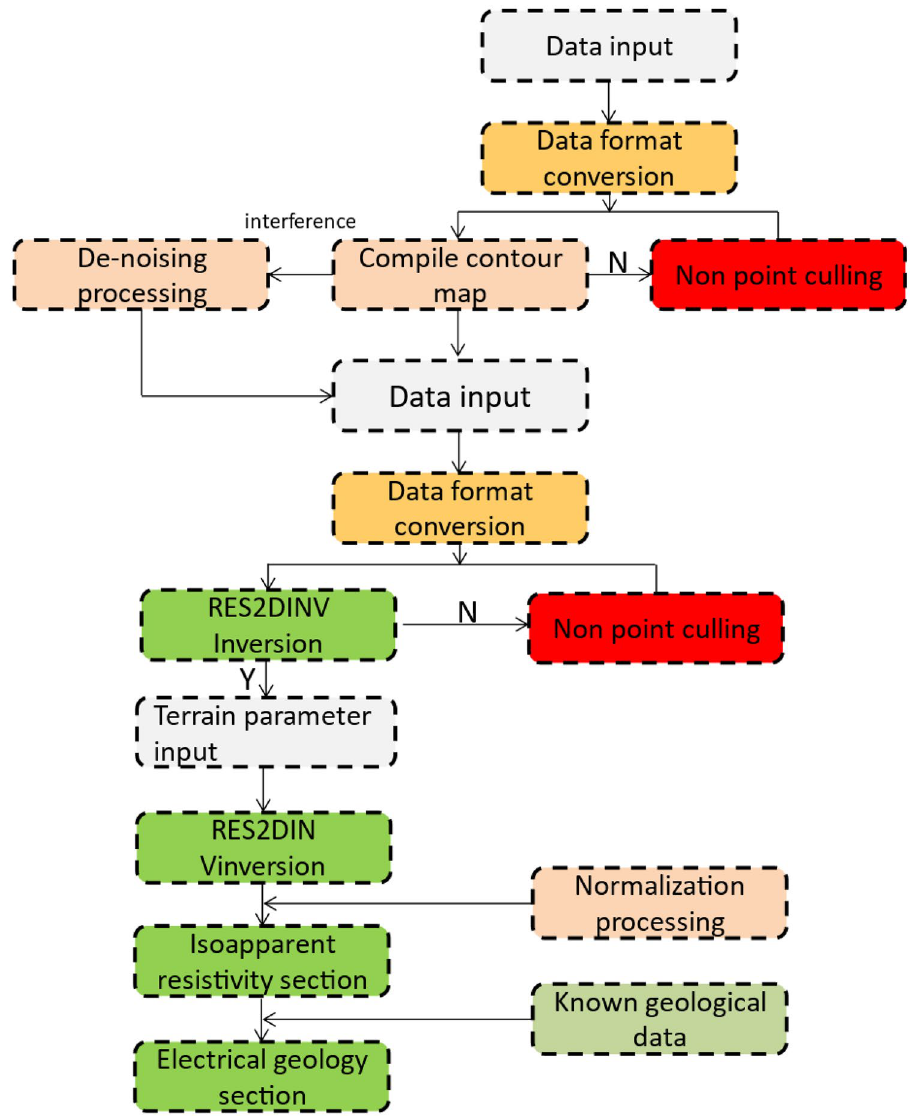
Figure 6. The flow chart of HDRM data processing.